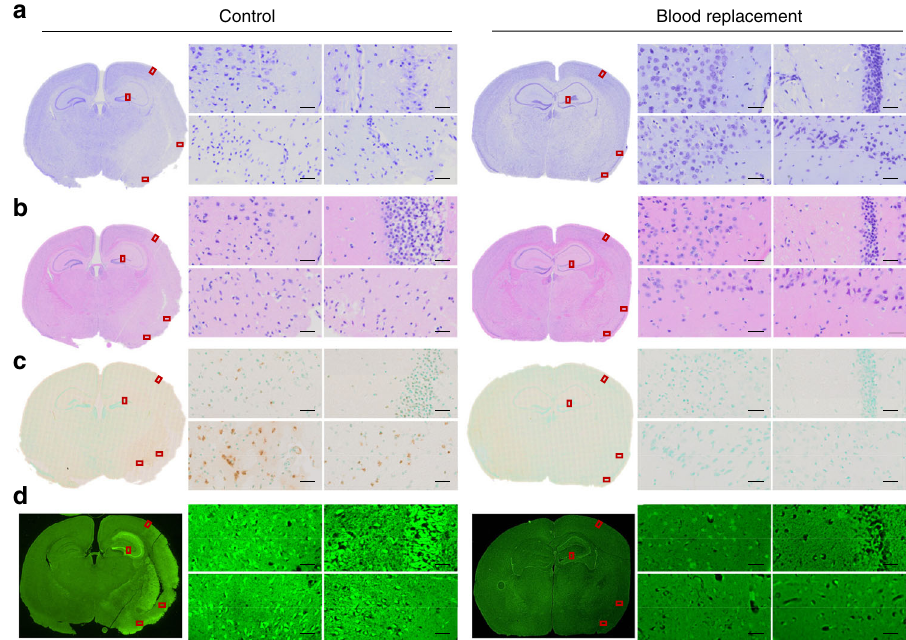
Fig. 2 Blood replacement protects the brain from cell death in stroke mice. Microscopic images of brain tissue taken from stroke mice underwent tMCAO for 90 min followed by 22.5h reperfusion. The blood replacement (BR) group received 500 µ l of blood from healthy donors (3~6 months old) at 6.5~7 h post stroke. a The Cresyl violet staining, b H&E staining, c TUNEL staining counterstained with Methyl Green, and d Fluoro-Jade C staining were performed on paraf fi n embedded brain slices. Red rectangles indicate the magni fi ed areas evaluated under ×40 magni fi cation. Both the cortex and striatum were evaluated. Experiments were repeated fi ve times with similar results and images were presentative of one mouse from fi ve mice per group. Scale bars = 20 µ